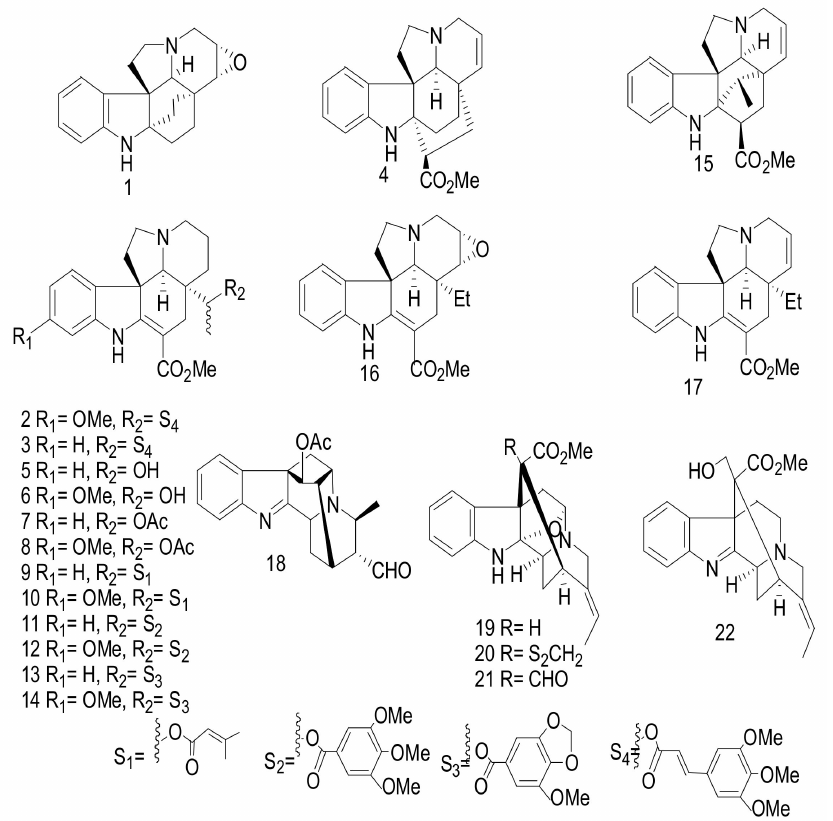
Figure 5. Compounds 1 – 22